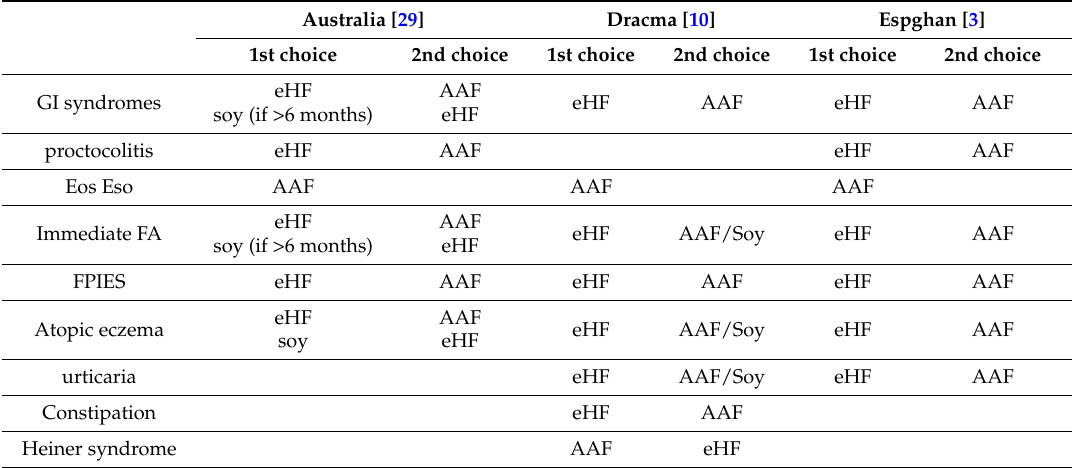
Table 3. Recommended therapeutic options according to different guidelines for different symptoms and signs of cow's milk